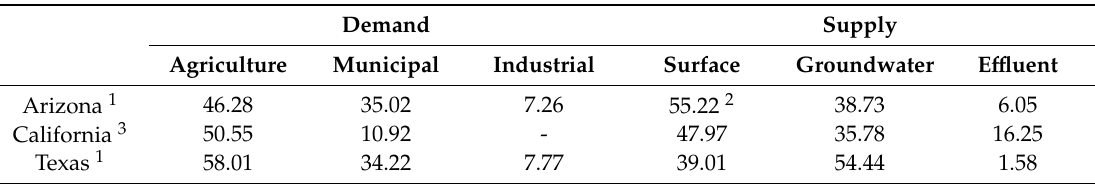
Table 2. Comparison of demand share for each sector and supply share from each source in percentage terms across the three